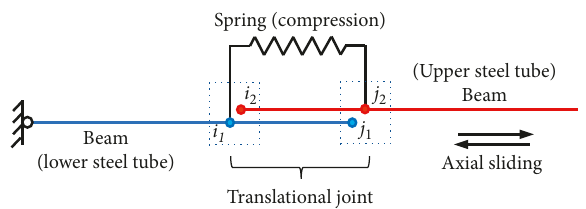
Figure 11: Spring-piston